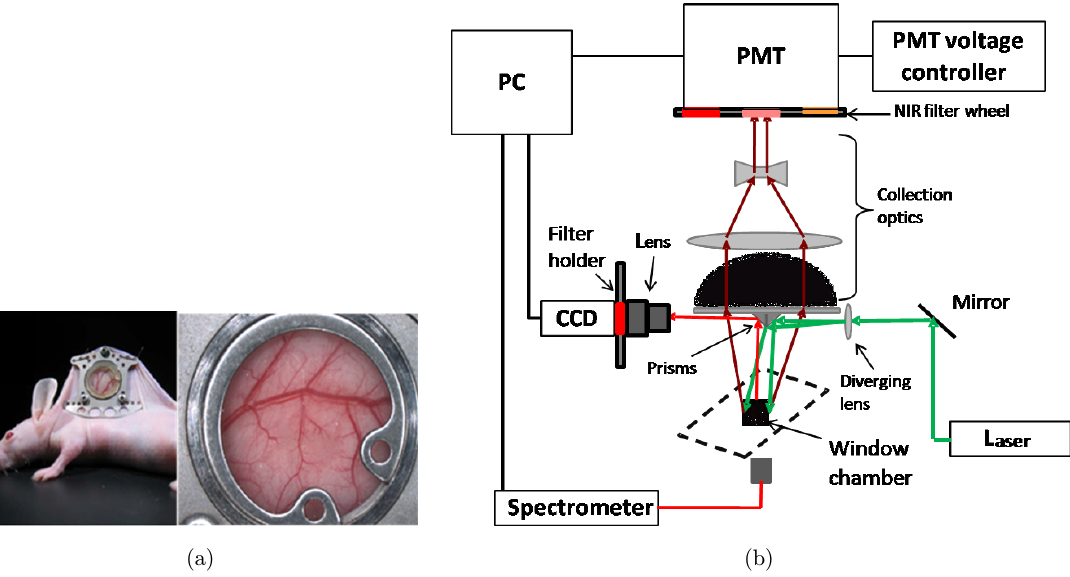
Fig. 1. Experimental setup. (a) Window chamber model shown in place on the imaging stage. (b) SOLD system: PMT, photo- multiplier tube; CCD, intensi¯ed charge coupled device camera for °uorescence imaging; PC, personal computer. Note that the data from the °uorescence spectrometer are not included in the present